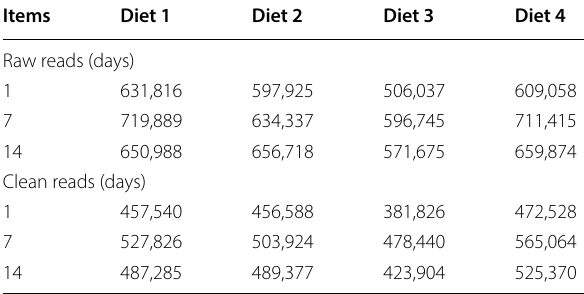
Table 2 Growth performance of weaned piglets with different diet treatments